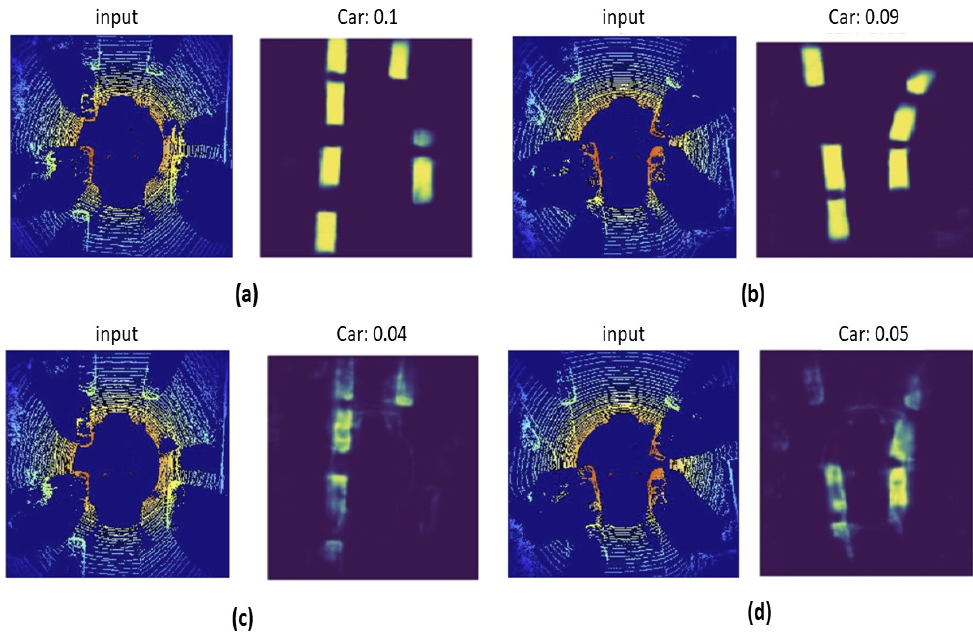
Figure 6. Comparison between model from scratch and model initialized with classification pre- trained weights: ( a , b ) shows prediction using pretrained weights, ( c , d ) shows prediction using the model trained from scratch .